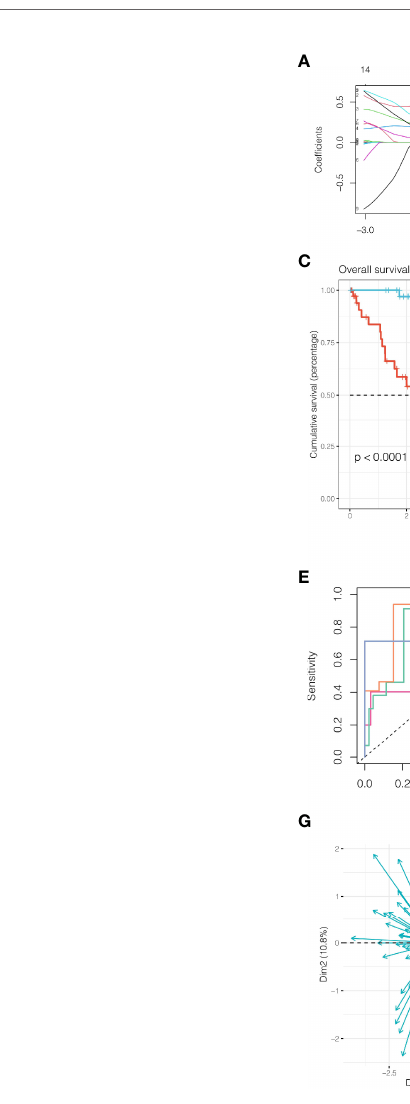
FIGURE 3 | Construction and validation of necroptosis-related prognostic model. (A, B) Six genes were selected to construct the prognostic model by Lasso regression. (C) Survival analysis of TCGA cohort. The prognosis was signi fi cantly worse in the high-NCPS group (P<0.0001). (D) Survival analysis of GSE84976 Cohort. The prognosis was signi fi cantly worse in the high-NCPS group (P<0.001). (E) ROC curve of TCGA cohort. The AUC values of the model in 1, 2, 3 and 5 years were 0.82, 0.86, 0.91 and 0.91, respectively. (F) ROC curve of GSE84976 Cohort. The AUC values of the model in 2, 3 and 5 years were 0.89, 0.95 and 0.88, respectively. (G, H) PCA analysis in TCGA cohort and GSE84976 cohort. It was found that the model could group UVM patients well in both the training cohort and the validation cohort.